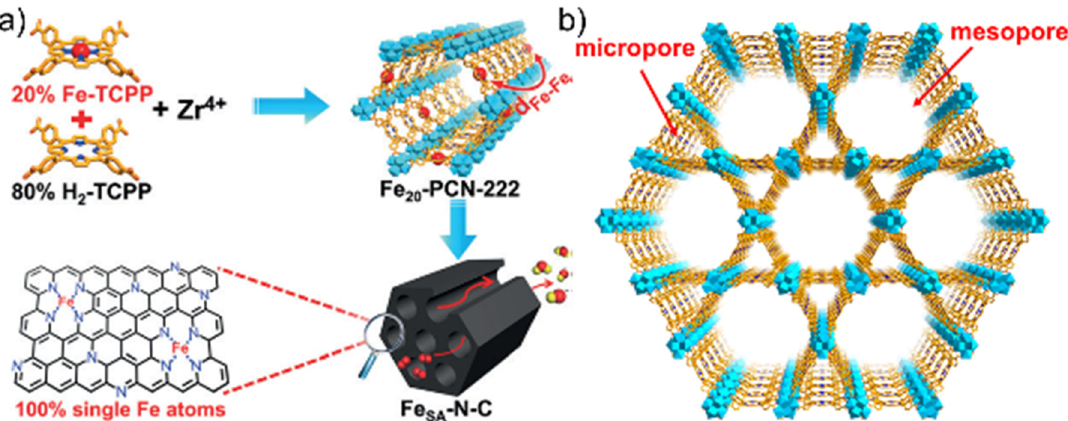
Figure 7. ( a ) Schematic synthesis of FeSA-N-C via the thermal decomposition of an Fe-containing metal–organic framework (MOF), PCN-222. ( b ) View of the 3D network of PCN-222 featuring mesochannels running through the c -axis. Reprinted and modified with permission from ref. [85]. Copyright (2018) John Wiley and Sons.